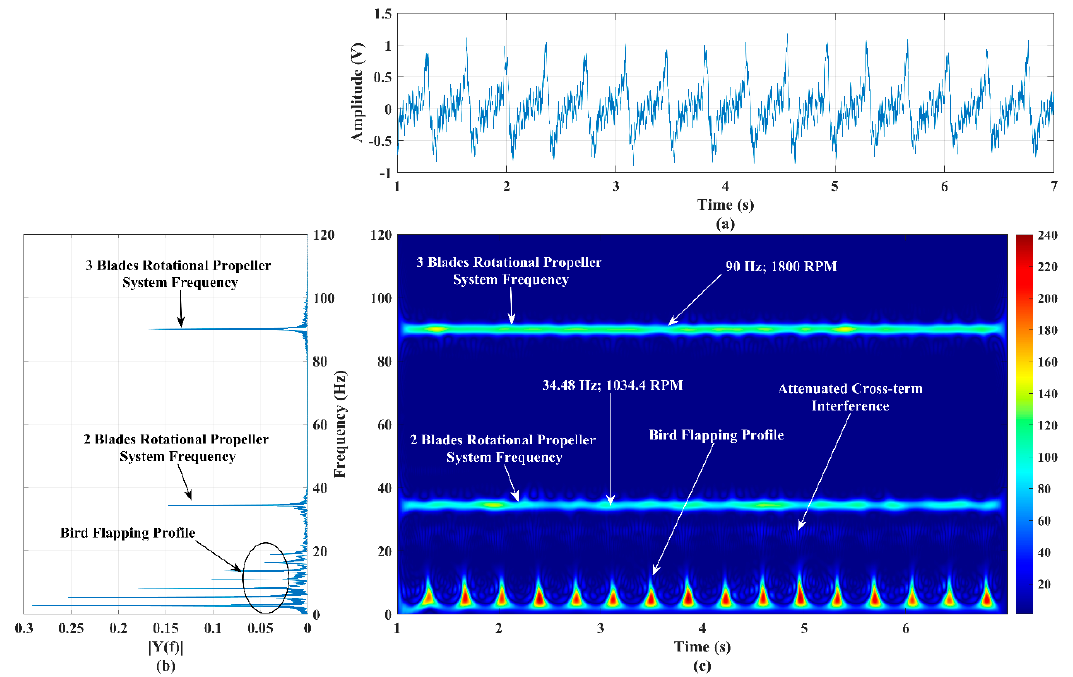
Figure 8. ( a ) Time − series plot, ( b ) power spectrum plot, and ( c ) micro − Doppler signature/pattern image designed using the improved SP − WVD for the simultaneous activities of three targets: two − blade and three − blade rotational propeller systems and a bionic bird’s flapping actions.